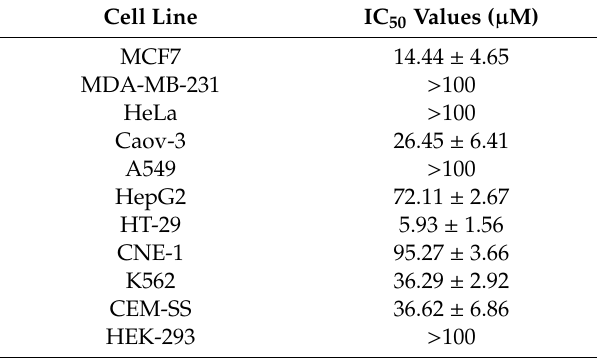
Table 11. Inhibitory effect of compound 29 against the estrogen-receptor-positive breast cancer cells HepG2, human colorectal cancer cells HT-29, human nasopharyngeal cancer cells CNE-1, human T-lymphoblastoid leukemia cells CEM-SS, human erythromyeloblastoid leukemia cells K562, and normal human embryonic kidney HEK-293 cells.